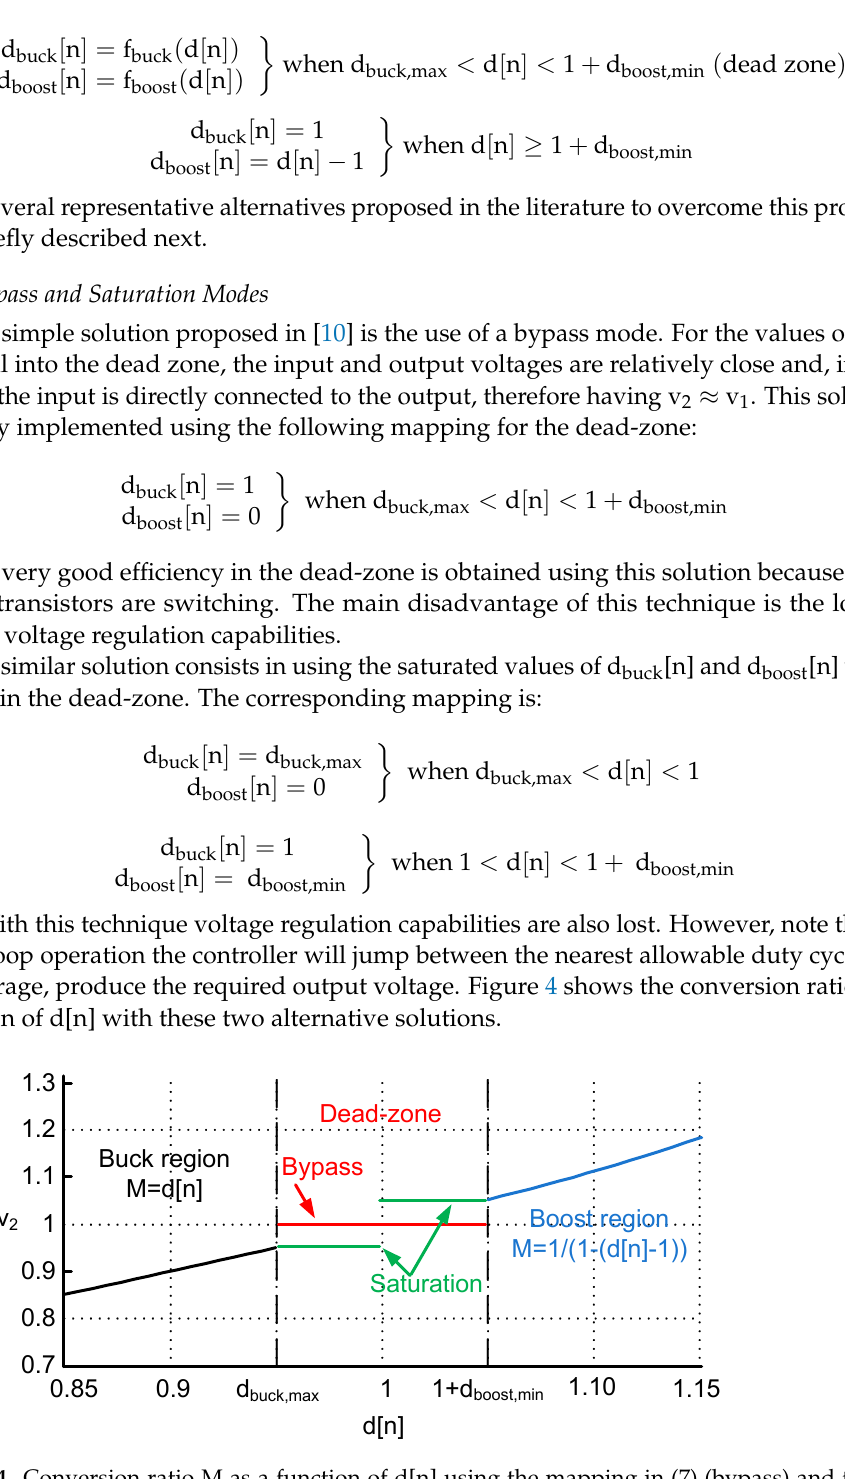
Figure 4. Conversion ratio M as a function of d[n] using the mapping in (7) (bypass) and that is described in (8) and (9) (saturation).